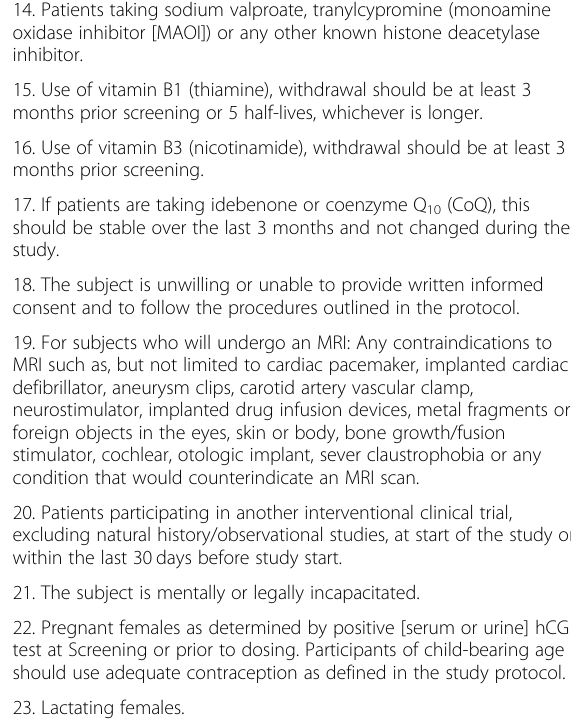
Table 1 Inclusion and exclusion criteria Inclusion